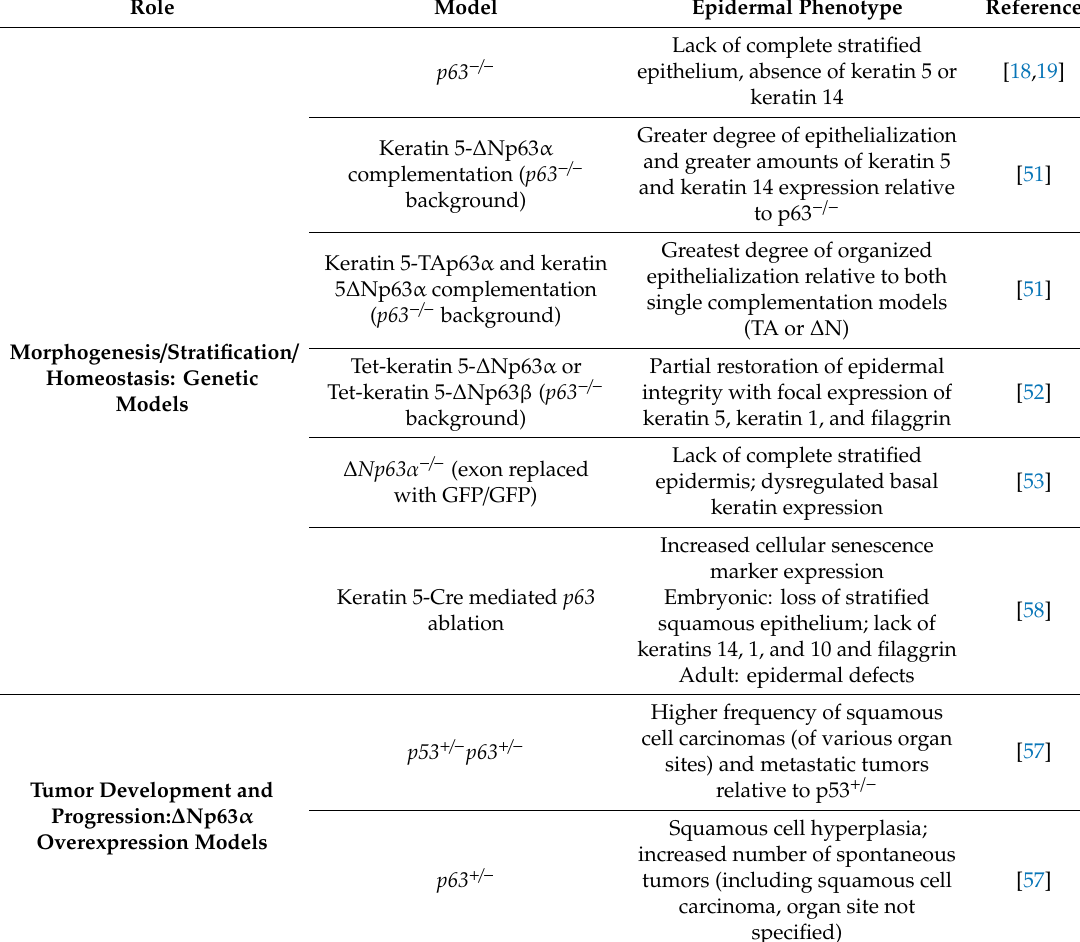
Table 1. Dissecting the role of ∆ Np63 α in development and cancer – murine